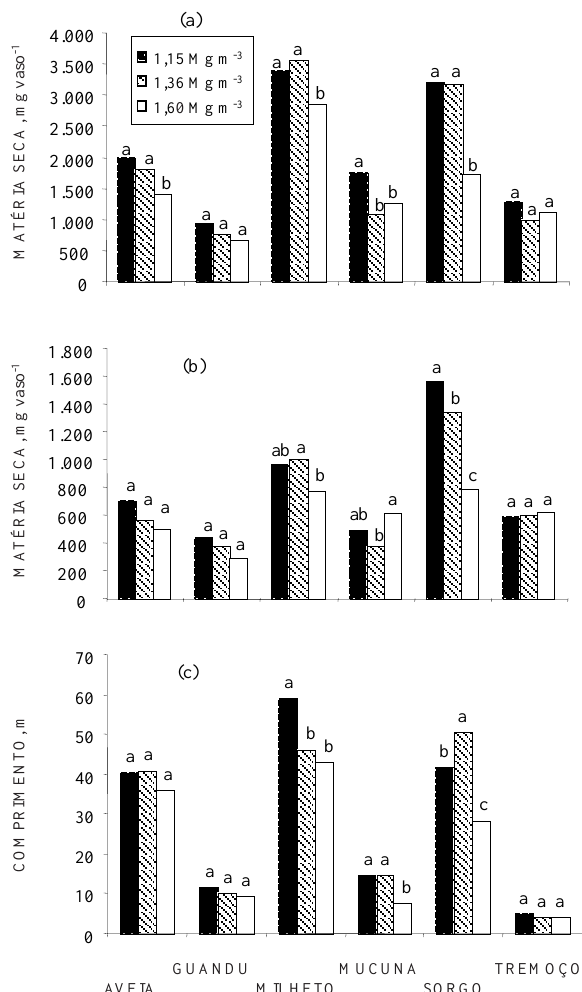
Figura 4. Produção de matéria seca da parte aérea (a), matéria seca (b) e comprimento (c) das raízes no vaso inteiro, considerando as densidades do solo impostas na profundidade de 15-18,5